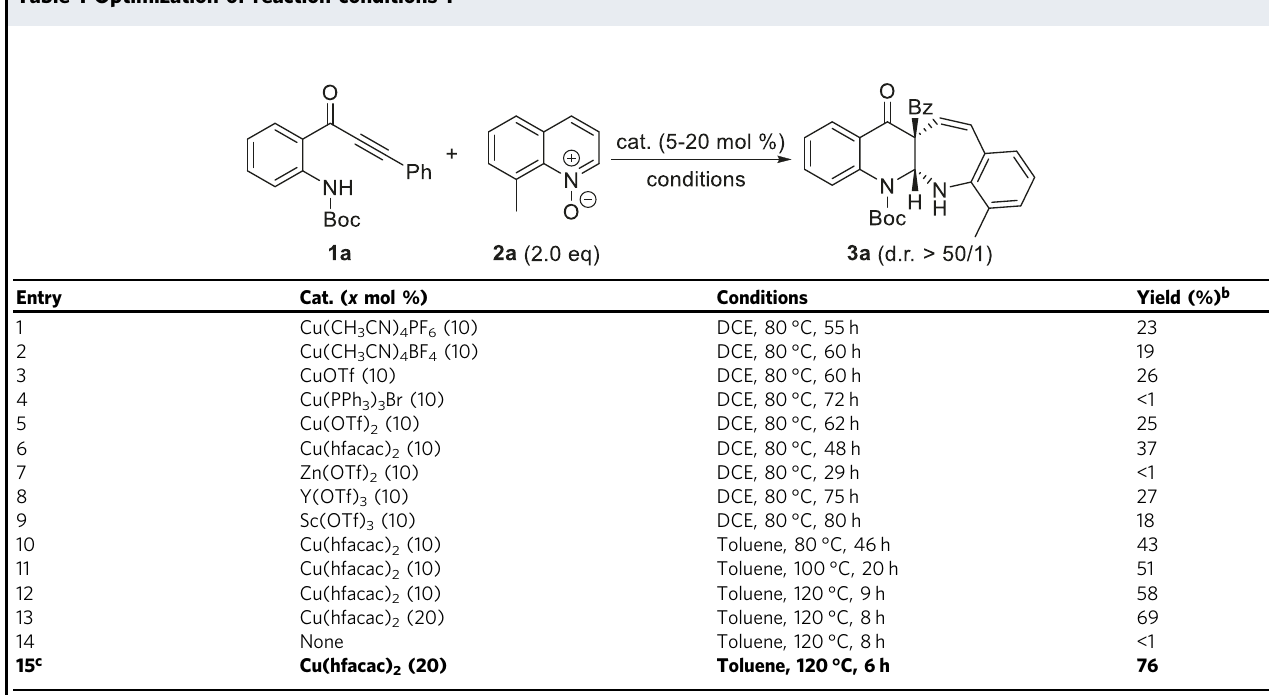
Table 1 Optimization of reaction conditions a